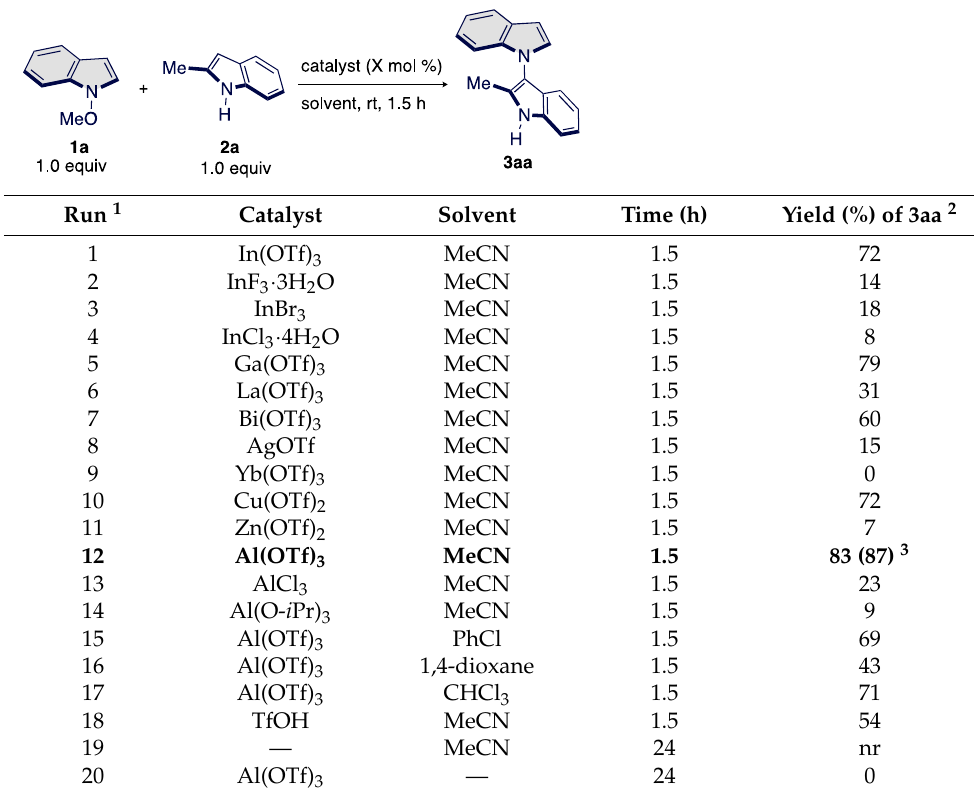
Table 1. Optimization of reaction conditions.